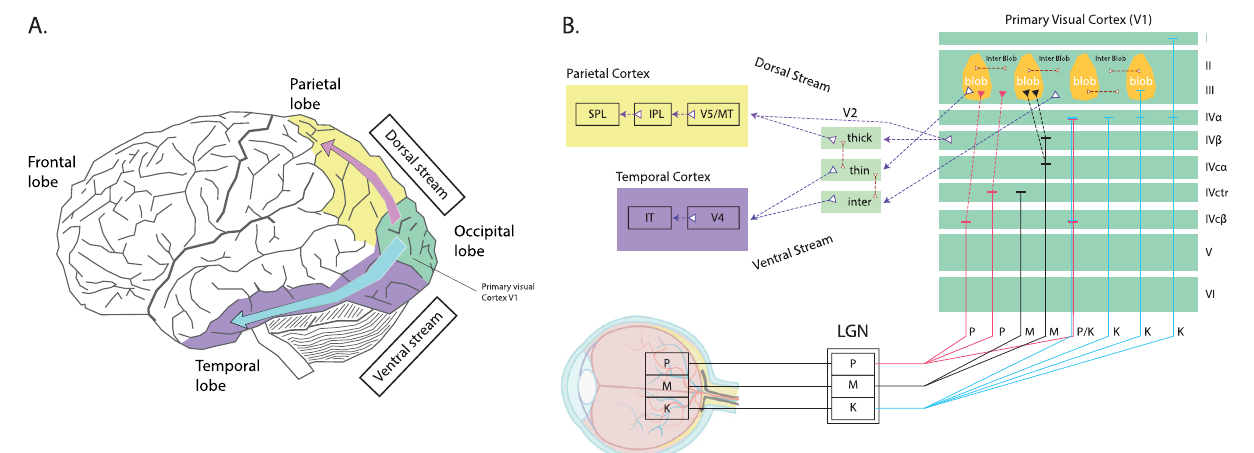
Fig. 5 Visual pathways and brain streams. A The ventral (purple) and dorsal (yellow) streams of visual information processing. B A detailed scheme of signal distribution from PC, MC, and KC visual pathways to the LGN and further to the primary (V1) and secondary (V2) visual cortex and subsequently to the dorsal or ventral stream. Redrawn from Casagrande & Xu 129